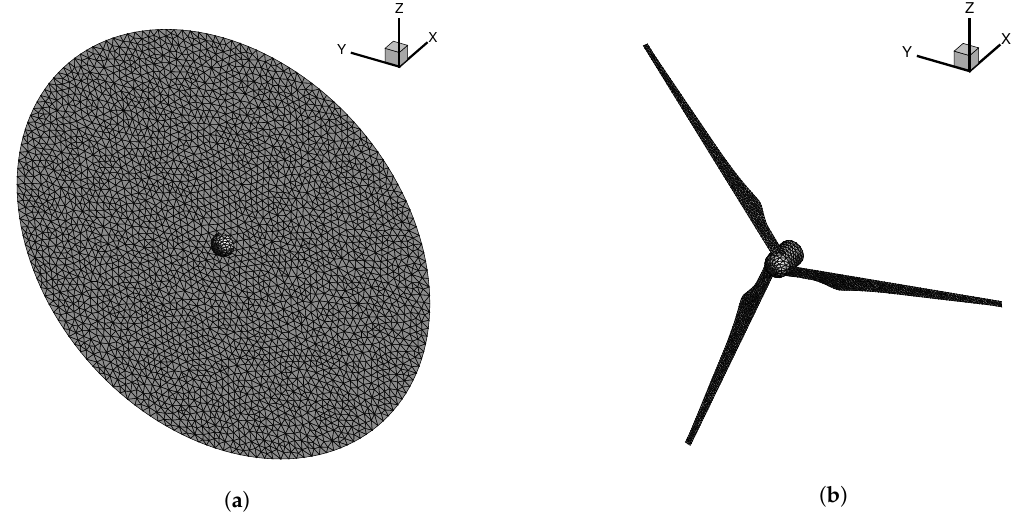
Figure 1. The unstructured triangular mesh of wind turbine models. ( a ) AD model. ( b ) AS